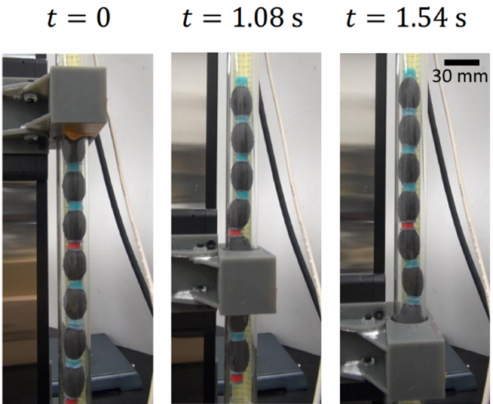
Figure 9. Peristaltic locomotion performed by the fabricated MAE crawler in a vertical pipe.